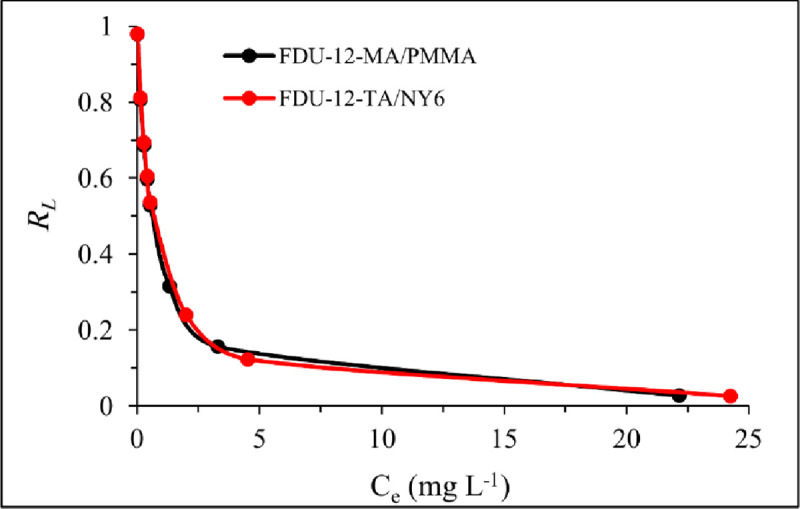
The calculated values of RL.